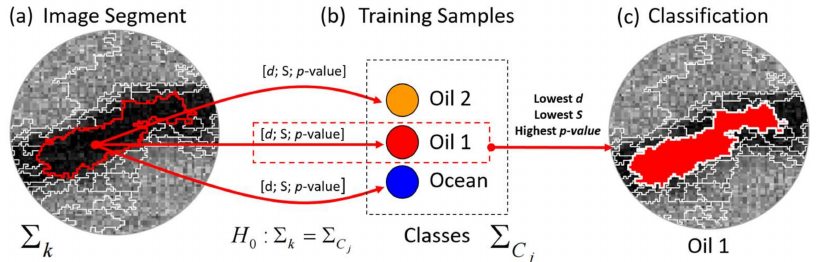
Figure 2. Demonstration of the region-based classification method: The algorithm calculates the distance ( d ), the statistical test ( S ) and p -value between the segment analyzed ( a ) and the training samples collected for each class ( b ). The class of the training sample, which presented the lowest d , the lowest S and the highest p -value in relation to the segment will be assigned to this segment ( c ). In this example, the segment used ( a ) was classified as Oil 1 ( c ), presenting the lowest d , the lowest S and the highest p -value related with this